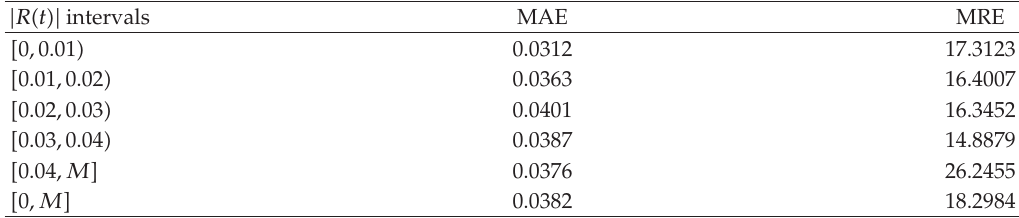
Table 3: The relationship between the fluctuation and the prediction by the absolute return intervals.